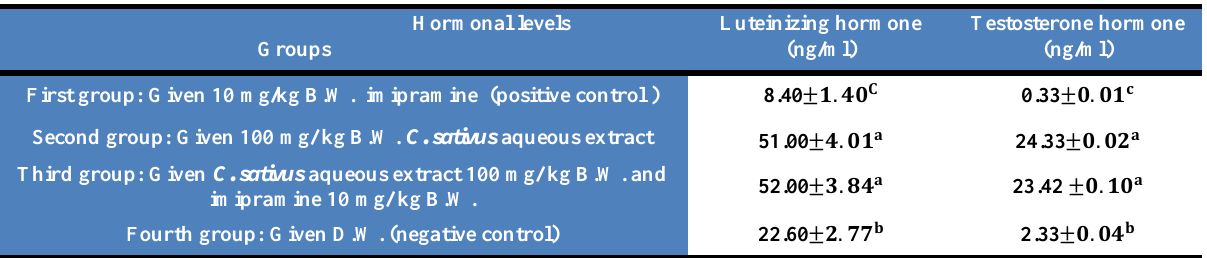
Table, 3: The effects of aqueous extract of C. sativus and imipramine on male mice body weights. Groups Pretreatment Body weights (g) post treatment (Day Zero) First group: Given 10 mg/kg B.W. imipramine (positive control) Second group: Given 100 mg/ kg B.W. Third group: Given C. sativus aqueous extract 100 mg/ kg B.W. and imipramine Fourth group: Given D.W. (negative